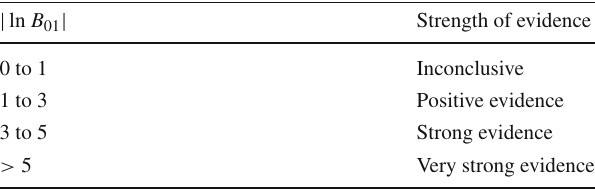
Table 2 The Kass–Raftery scales for interpreting the Bayes